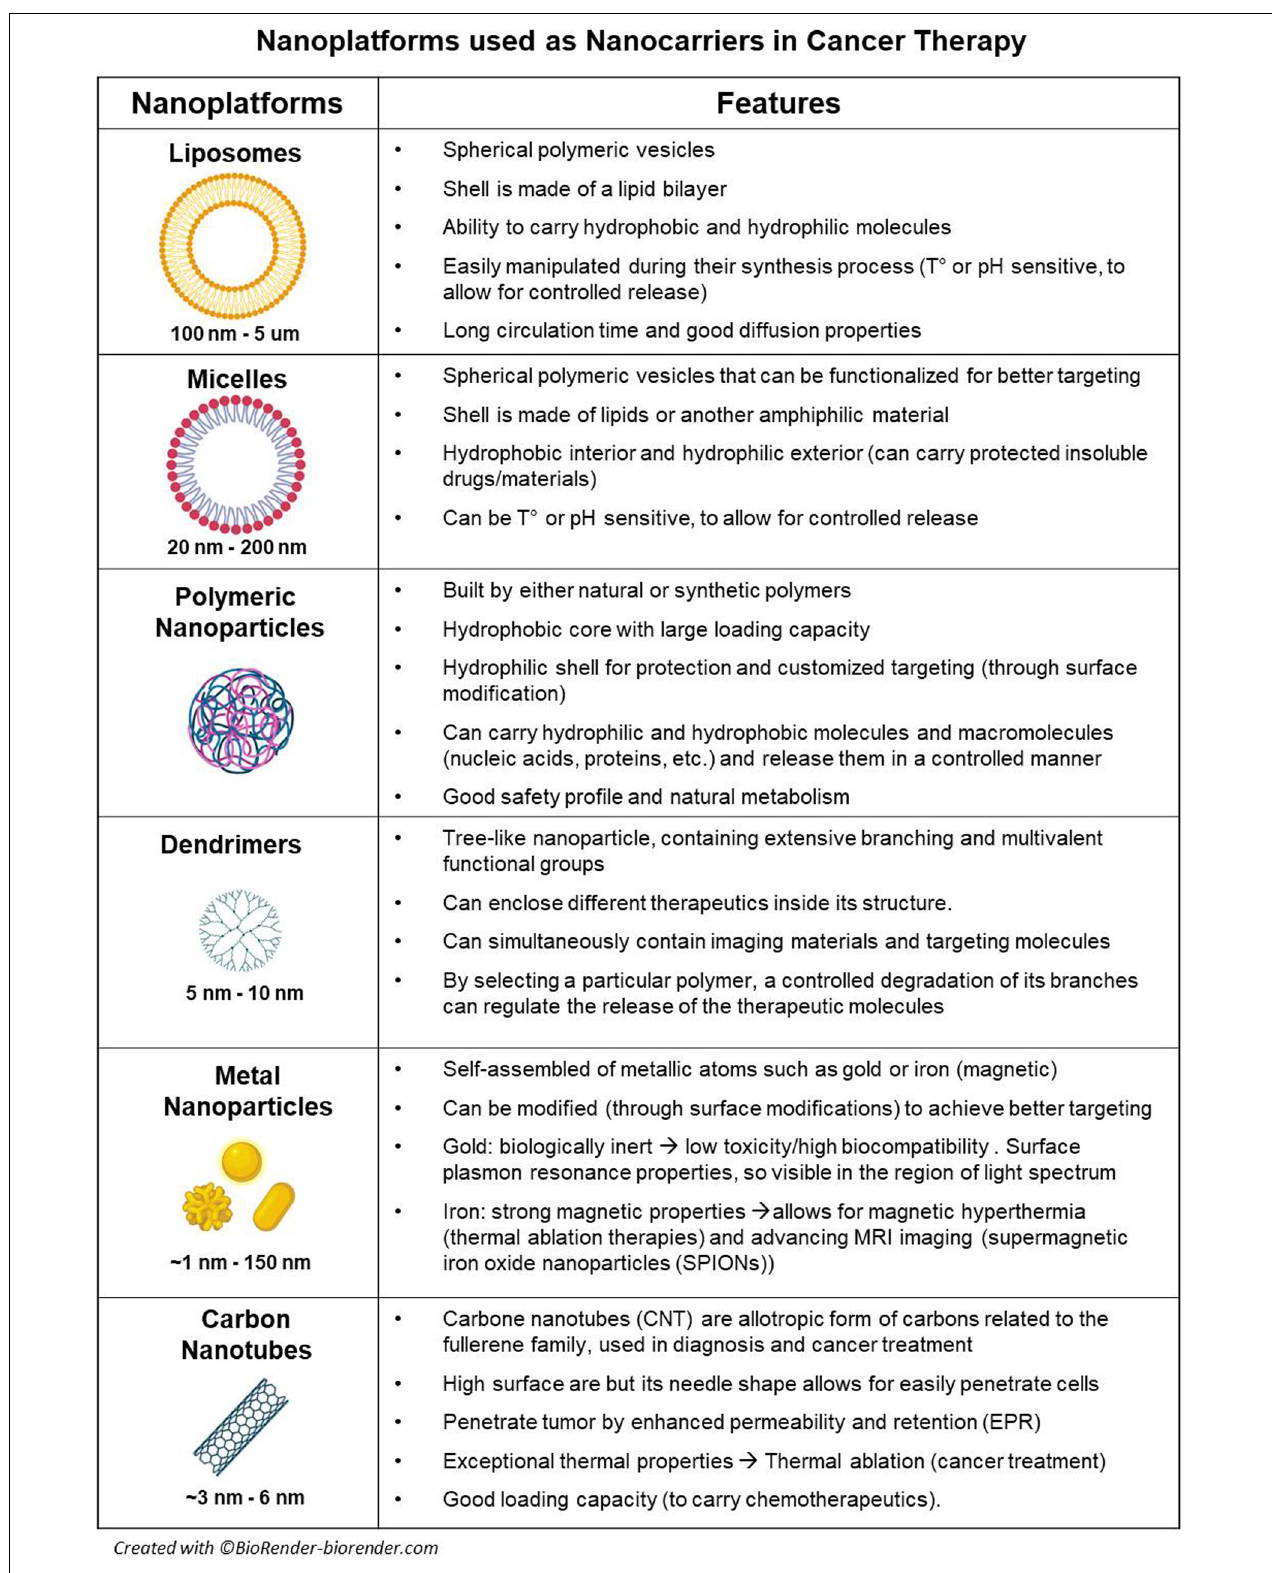
FIGURE 1 | Nanoplatforms used as nanocarriers in cancer therapy.